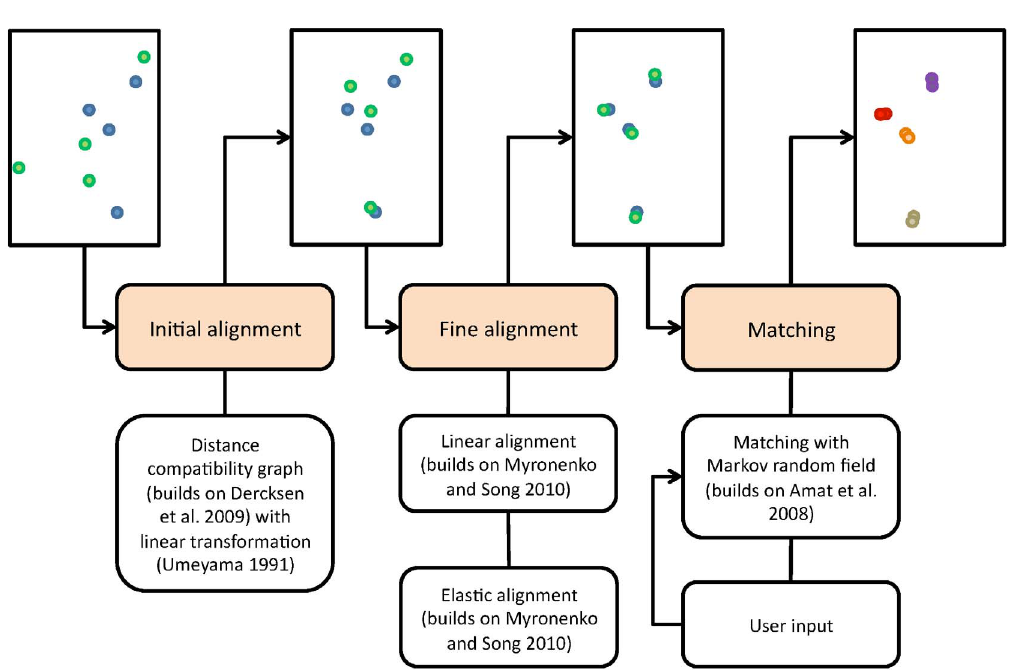
Figure 2. Computational methods. Top and middle: Illustration of two neighboring sections (view from top) and main processing steps. Bottom: algorithmic details and references. Endpoints are illustrated in blue and green. The initial alignment computes a coarse, linear alignment from a subset of endpoints. The fine alignment moves endpoints closer in two steps: a linear alignment followed by an elastic alignment. The matching determines pairs of corresponding endpoints (indicated in different colors), which are finally connected across sections (not